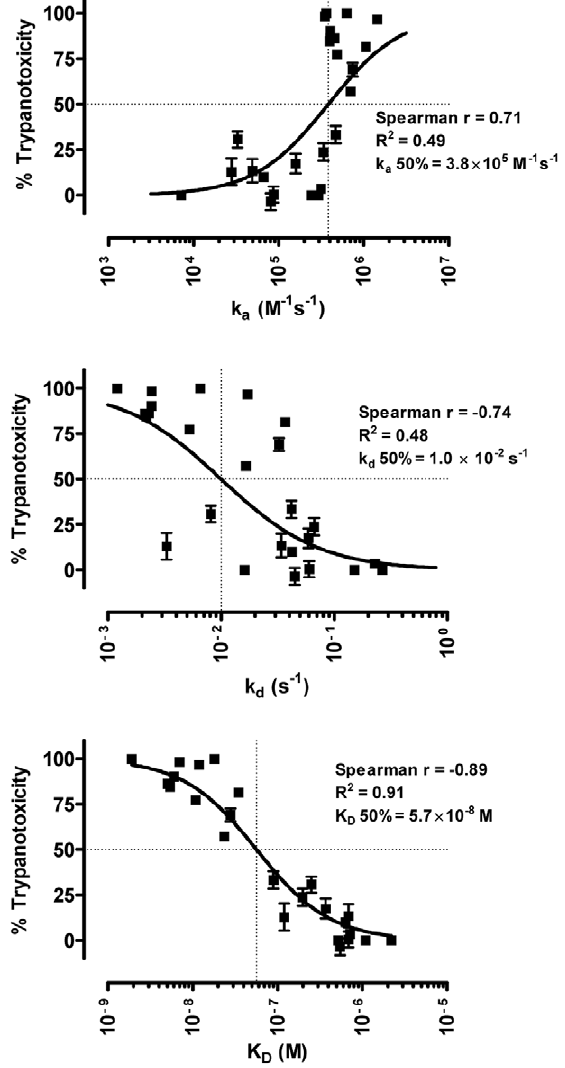
Figure 3. Analysis of the characteristics of the available panel of trypanotoxic Nanobodies. Non-linear three parameter regression and non-parametric Spearman correlation analysis of the trypanotoxic potential in function of k a , k d and K D respectively for all trypanotoxic Nbs ( n =25). R 2 values, Spearman correlation coefficients (r) and half maximal (50%) effective kinetic constant values are indicated in each graph.